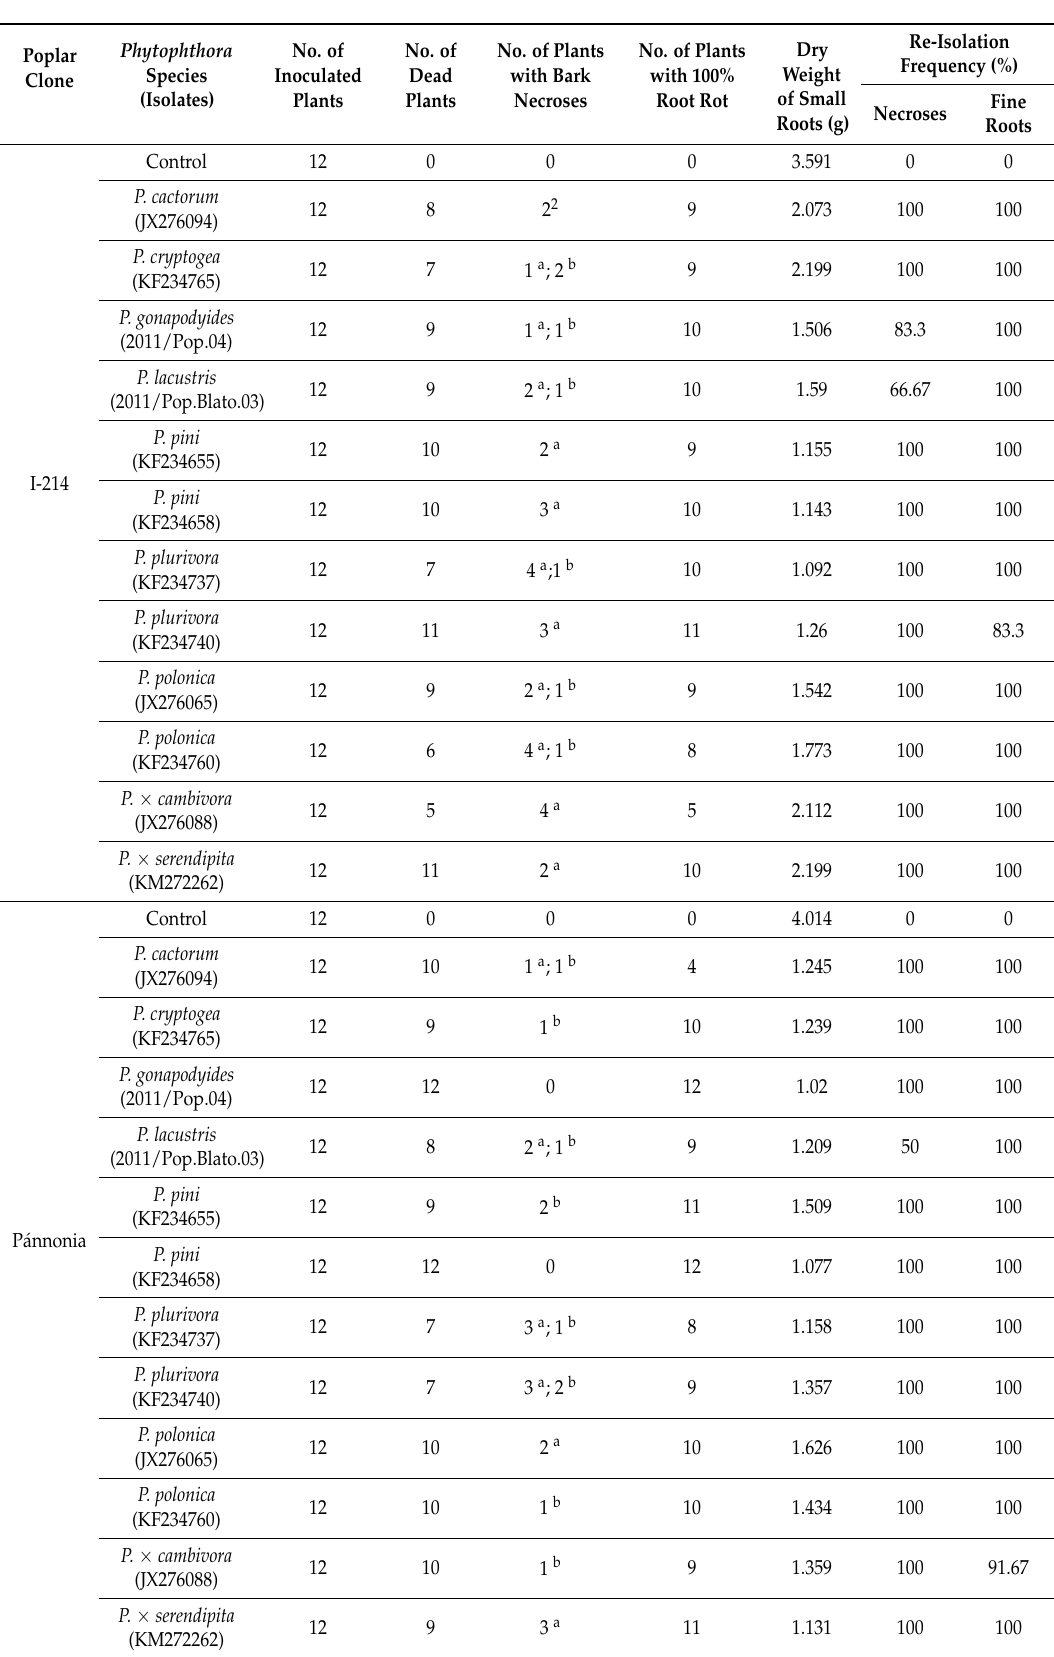
Table 2. Pathogenicity of nine Phytophthora species to Populus × euramericana clones I-214 and P á nnonia in the soil infestation test after 10